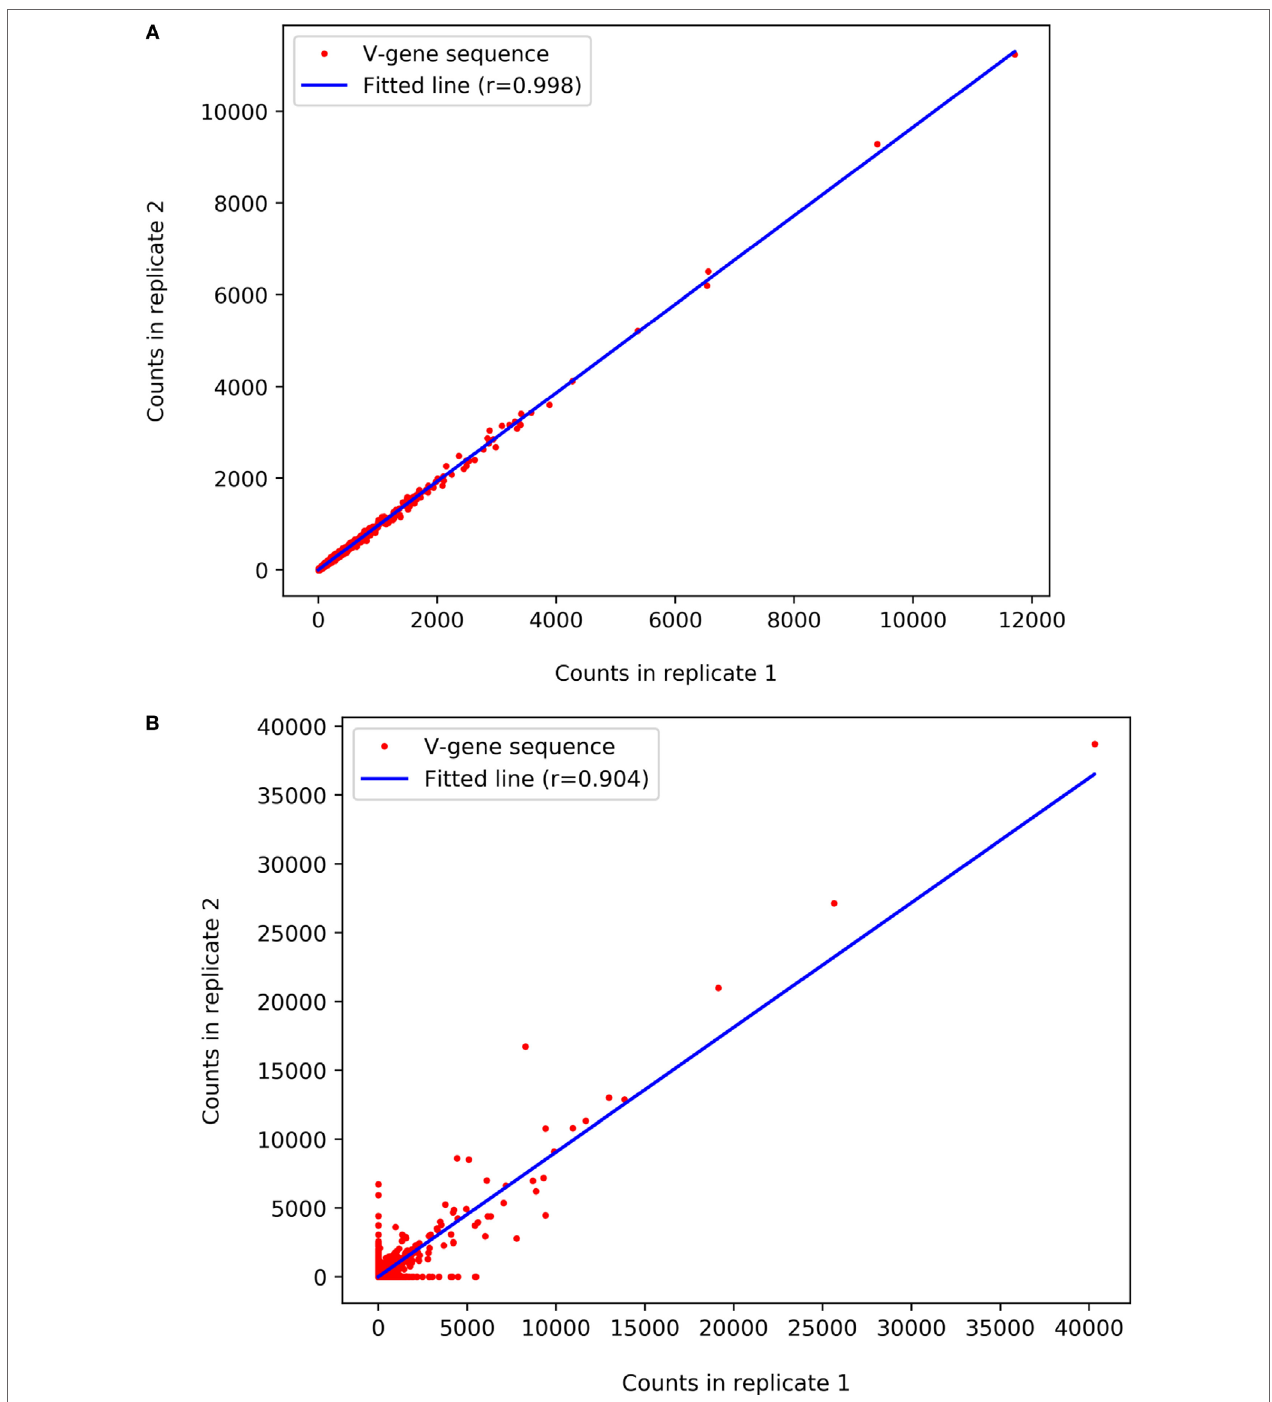
FIguRe 10 | Pearson correlation between two next-generation sequencing replicates. Each dot represents a unique amino acid variable region. The X and Y axes indicate the number of times each such read appears in the first and the second replicate, respectively. (A) Replicates with high reproducibility and (B) with lower reproducibility between